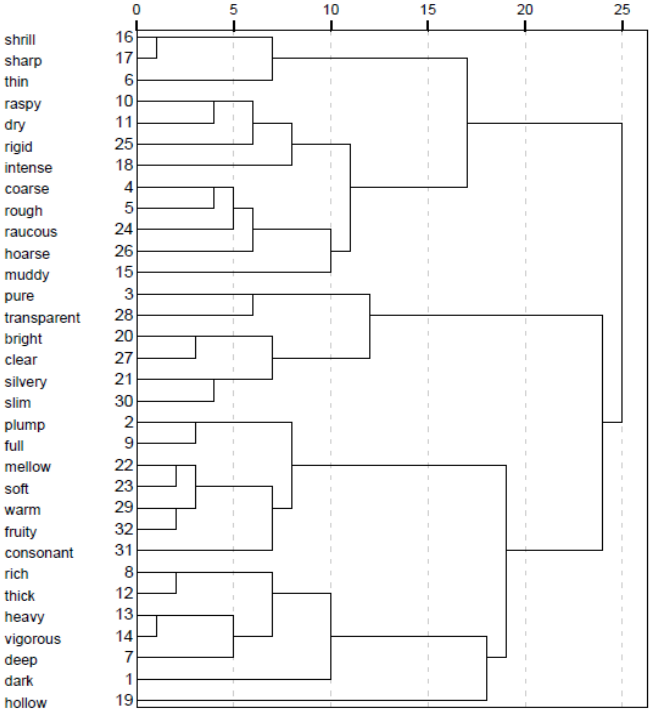
Figure 3. A cluster diagram of 32 timbre evaluation terms.